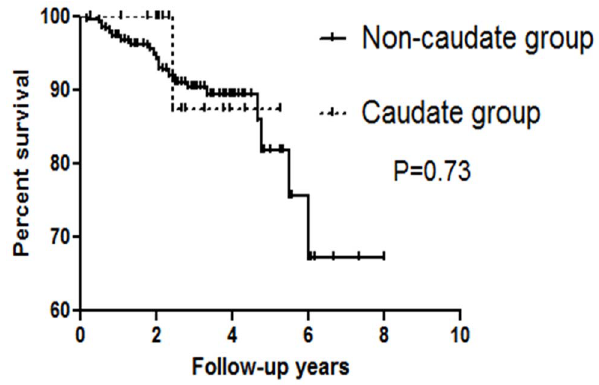
Figure 3. Cumulative overall survival in hepatocellular carci- noma (HCC) patients stratified by the site of tumor. There was no statistically significant difference in the overall survival rate between caudate HCC and non-caudate HCC (P=0.73).